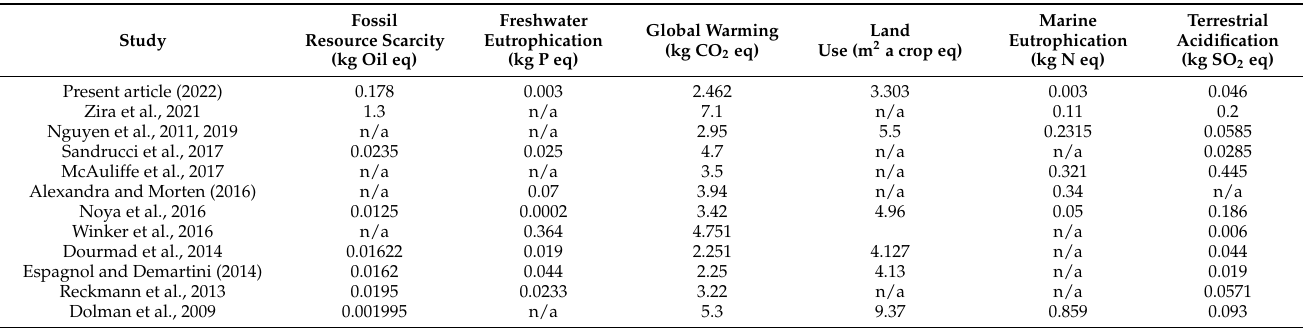
Table 3. Pig meat production environmental impact per unit of production (kg) system per- formance across conventional systems in our study’s research.